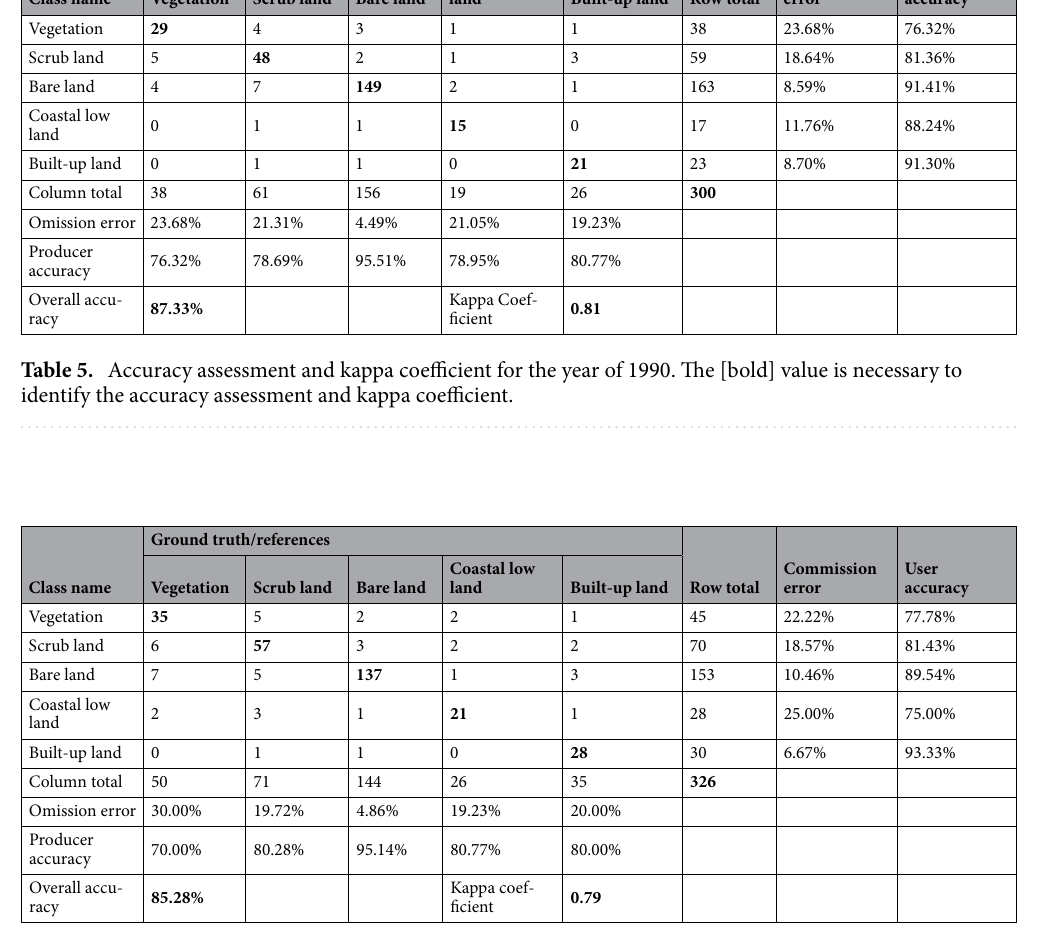
Table 6. Accuracy assessment and kappa coefficient for the year of 2000. The [bold] value is necessary to identify the accuracy assessment and kappa